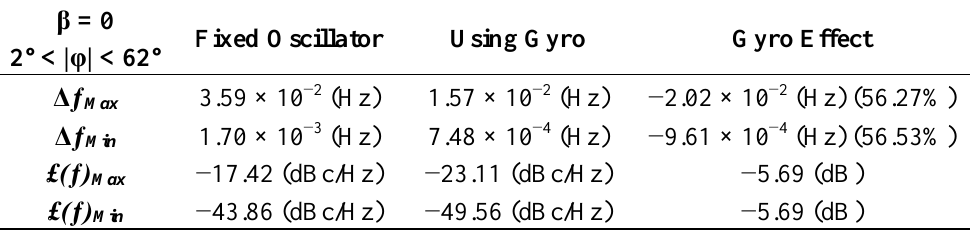
Figure 11. Average instability caused by steady state load. ( a ) Frequency deviation; ( b ) Phase noise. Table 2. Average efficiency of gyroscopic mounting for steady state load.